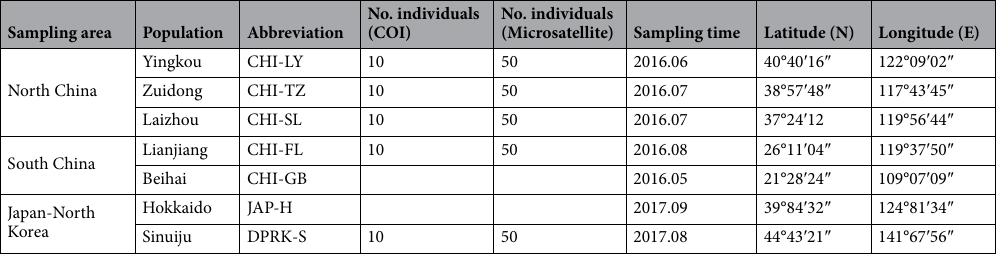
Table 1. Sample details for the seven populations of the Manila clam.